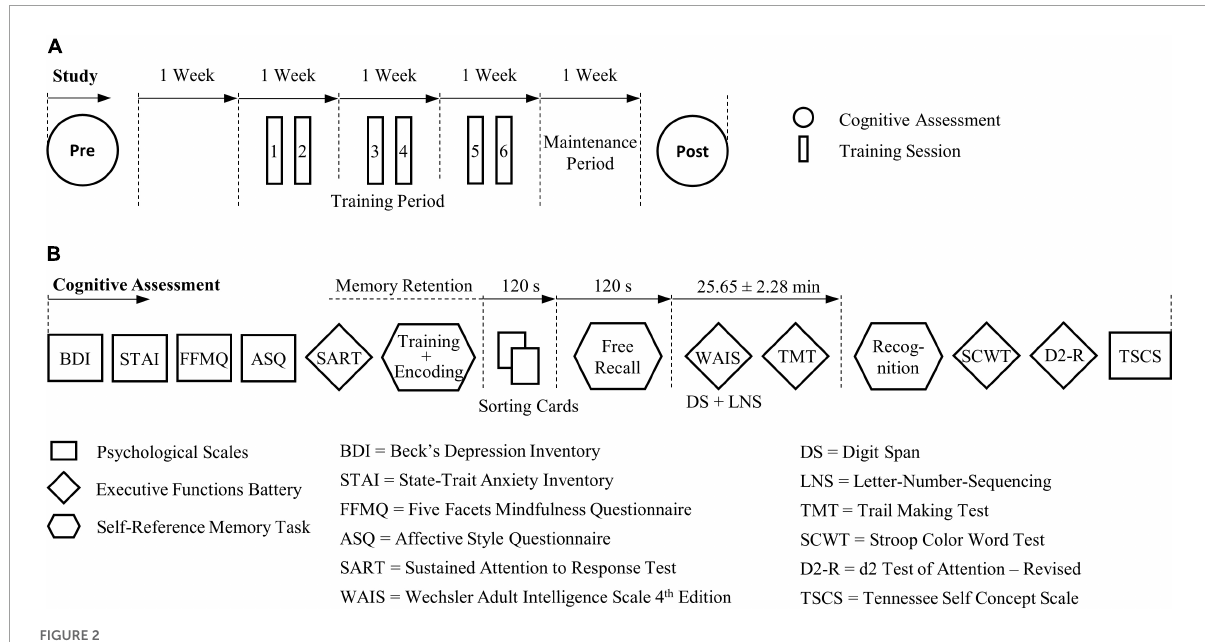
FIGURE2 Course of study and procedure of the cognitive pre- and post-assessment. (A) Cognitive effects that were sustained 1 week after self-regulation training were assessed. (B) The experimental procedure was identical between groups and tests. For the self-reference episodic memory task parallel task versions were devised for the pre- and post-test,